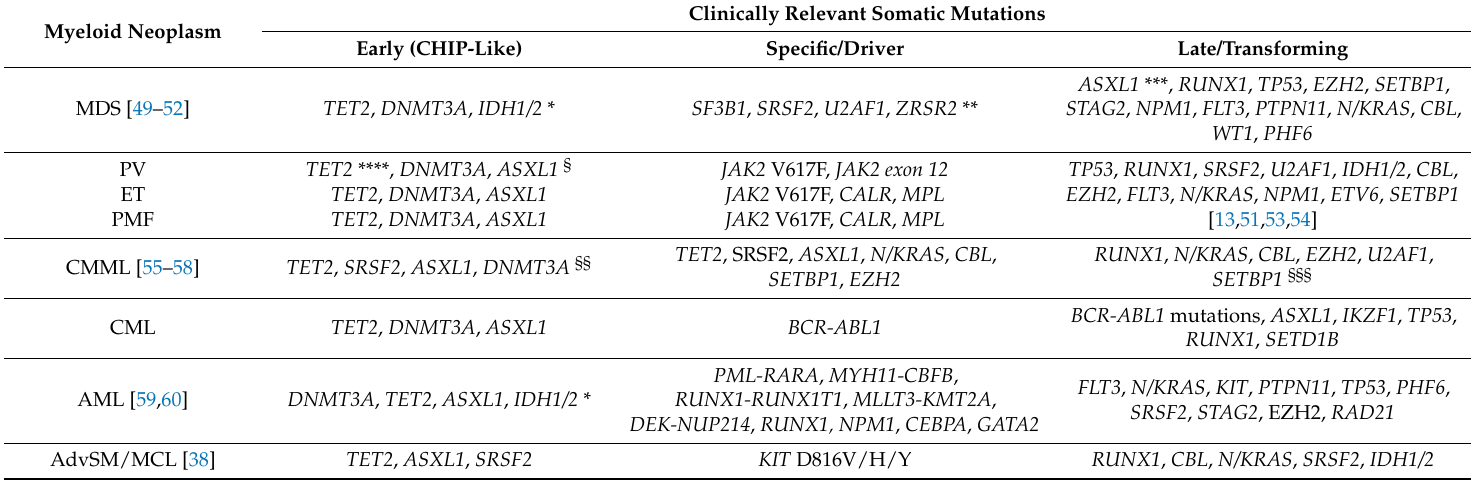
Table 2. Some clinically relevant somatic mutations detectable in myeloid neoplasms based on oncogenic potential and risk to transform to secondary acute myeloid leukemia